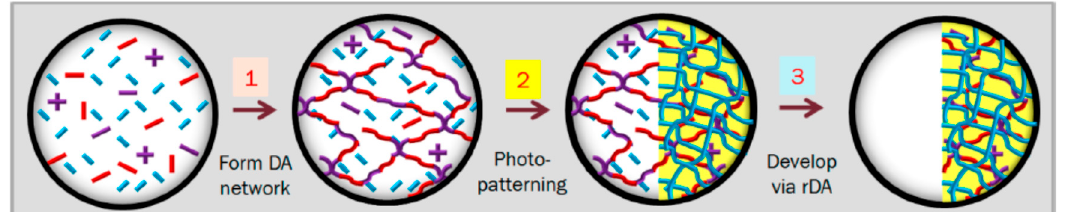
Figure 2. The liquid mixture of monomers is cast as a thin film and heated up to 70 °C, at which temperature the Diels–Alder (DA) network is formed, leaving unreacted monomers. As the monomer conversion exceeds the Flory–Stockmayer threshold for gel point, the film solidifies (Stage 1). Using a photomask, the film is UV irradiated to form the polyacrylate network (Stage 2). When the film is heated to 120 °C the thermoreversible DA network depolymerizes. The resulting liquid monomers can be washed away easily, leaving intact the polyacrylate network (Stage 3). Reprinted